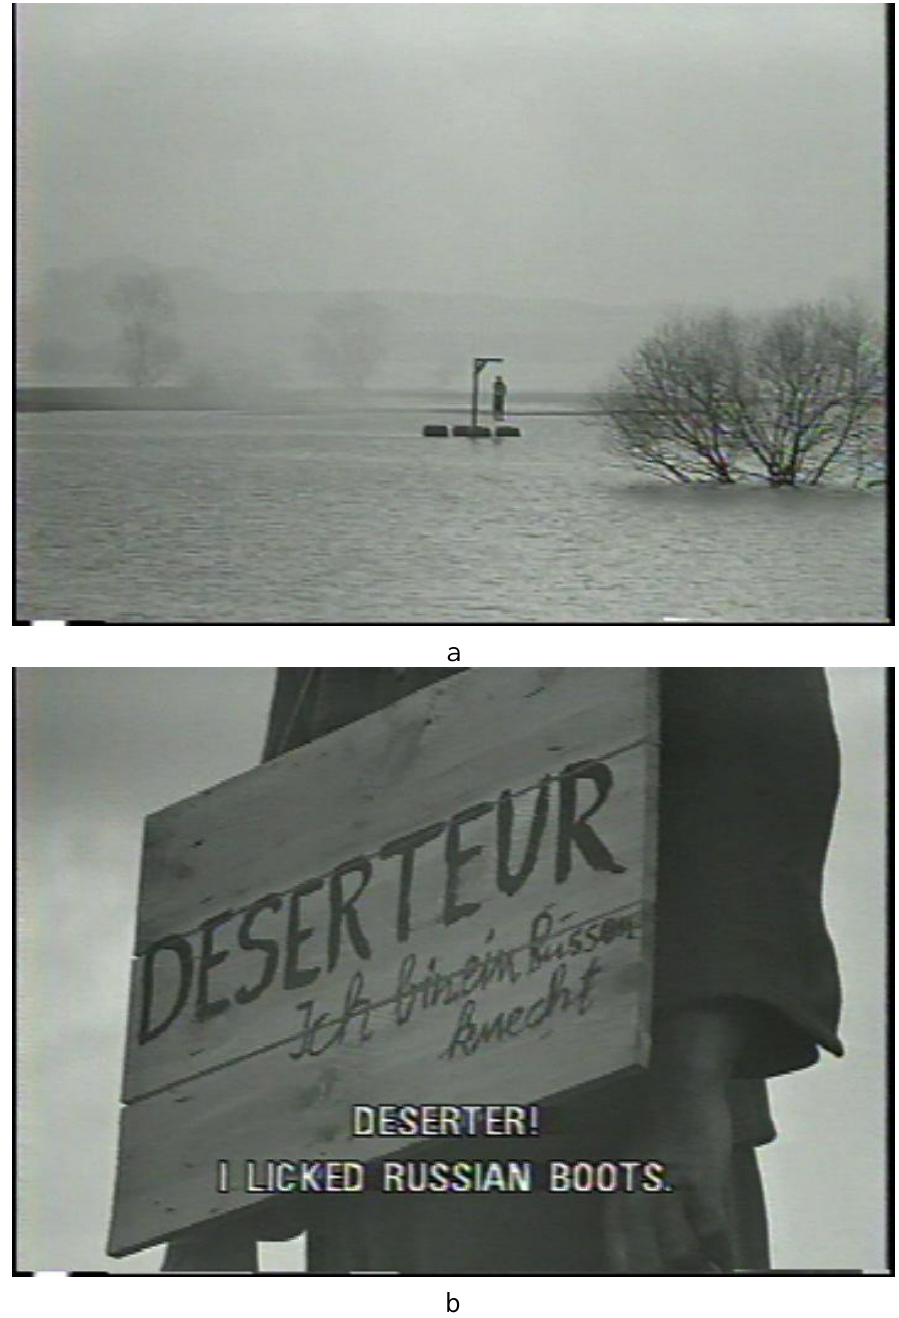
Figure 2. a. A gallows looms above the foggy German river in I was Nineteen . b. A close look at reveals the reason for the brutal death: deviation from the shared beliefs and objectives of the national